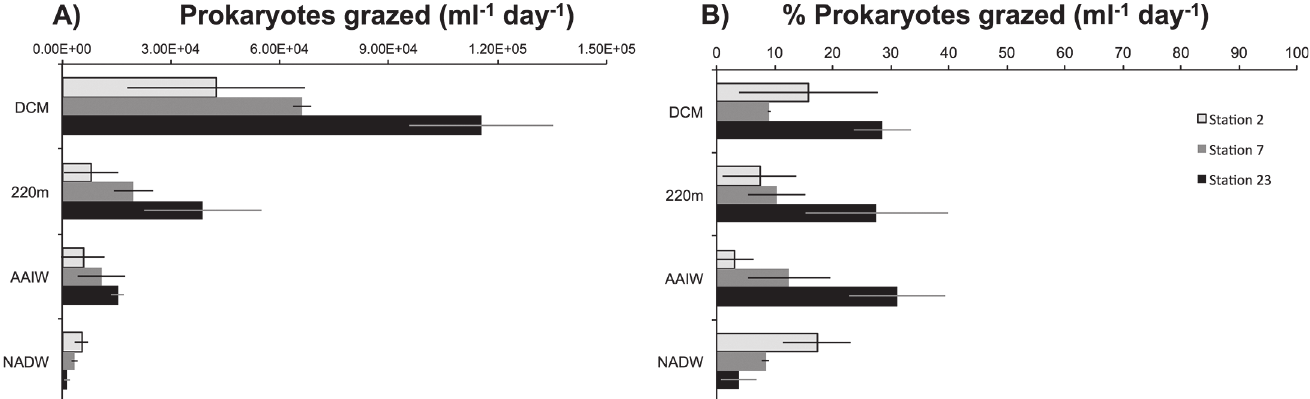
Fig 4. Fig 4A: Community grazing rates of prokaryotes represented as the number of prokaryotes grazed per day. Fig 4B: Community grazing rates of prokaryotes as a percentage of prokaryote standing stock grazed. Error bars represent the standard deviation of the mean (n = 2).